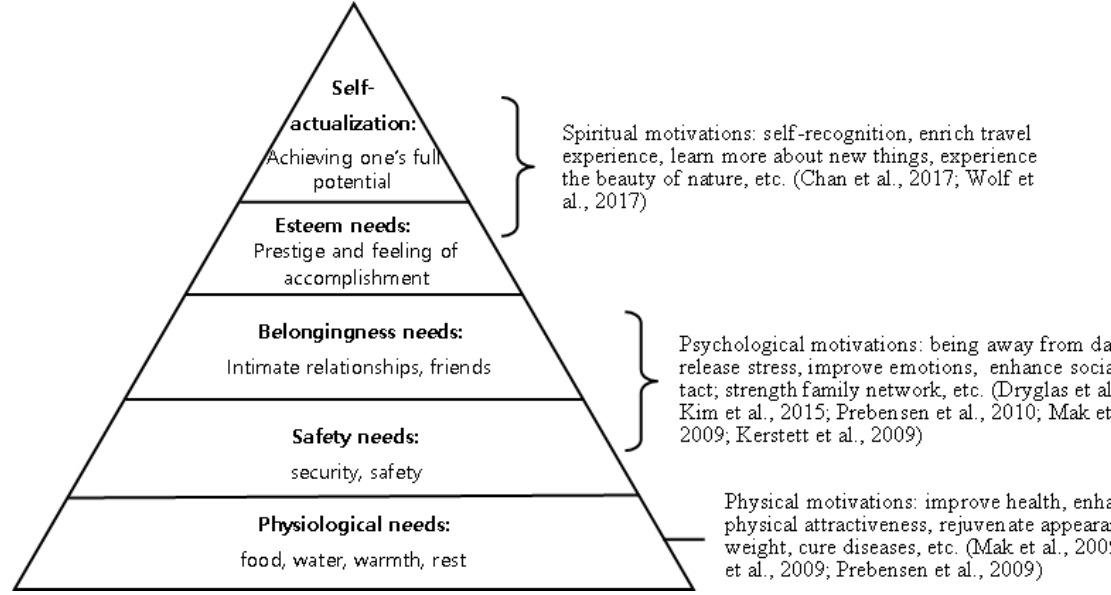
Figure 4. Correspondence between the restorative motivations of visitors in natural environments and Maslow’s hierarchy of needs.